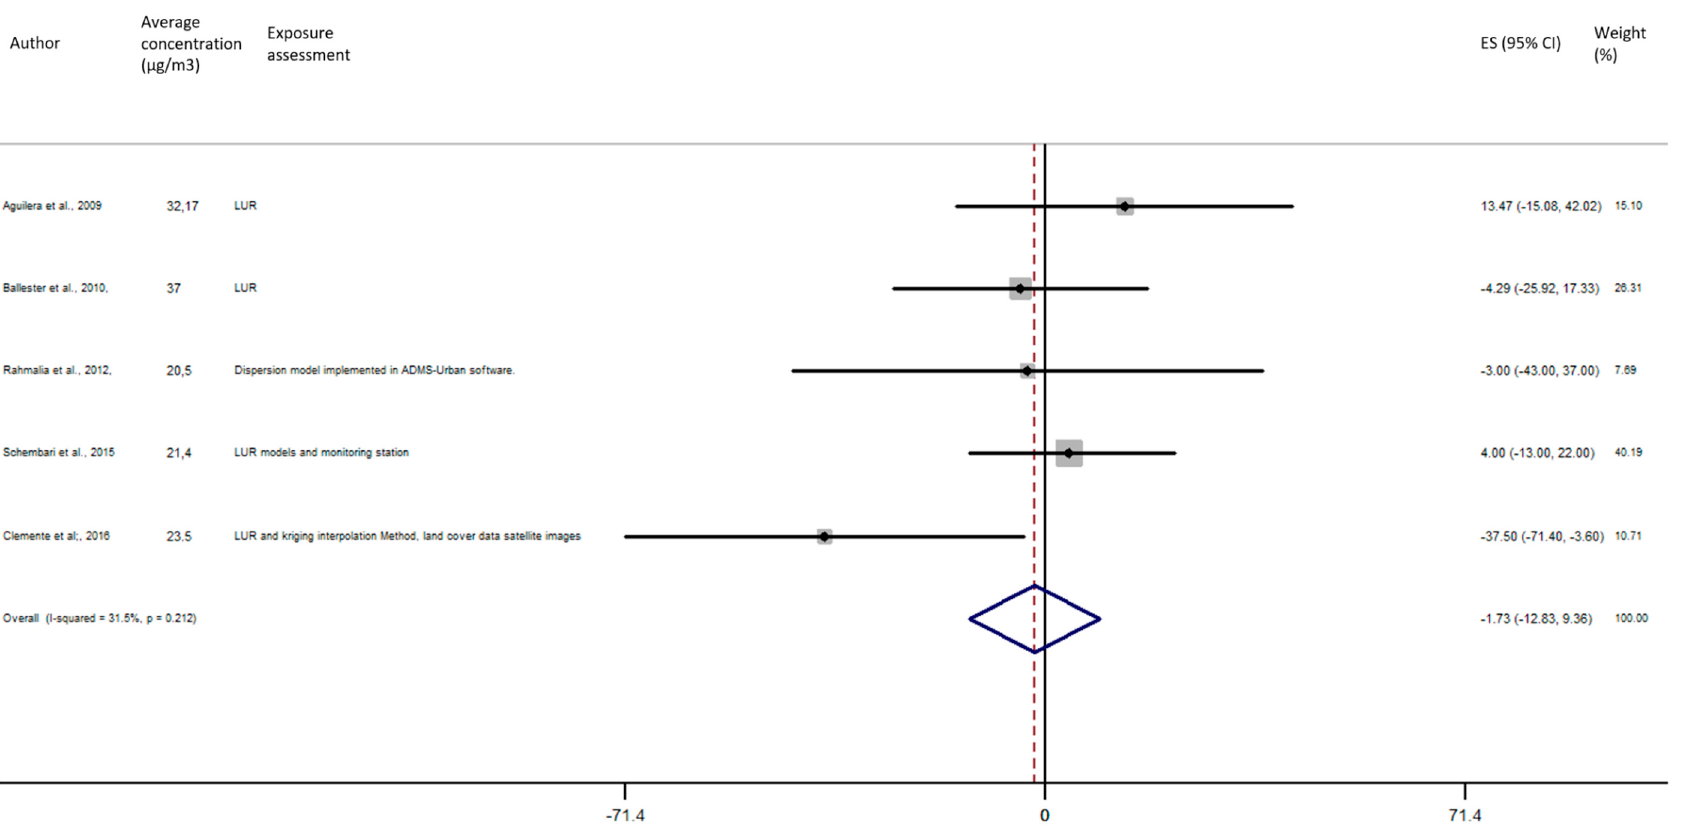
2 exposure during the third trimester of